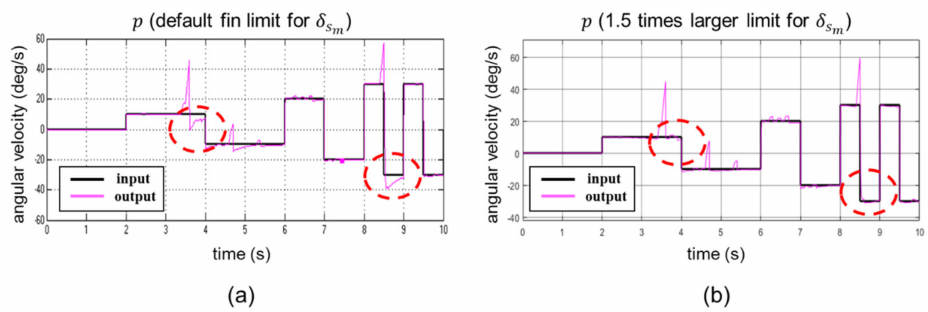
Figure 13. Rolling velocity control result when the control fin limit is set to a given default value ( a ) and 1.5 times larger ( b